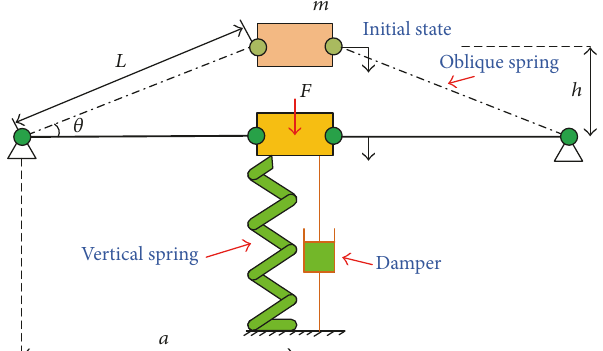
Figure 1: Model of seismic isolated structure with QZS.